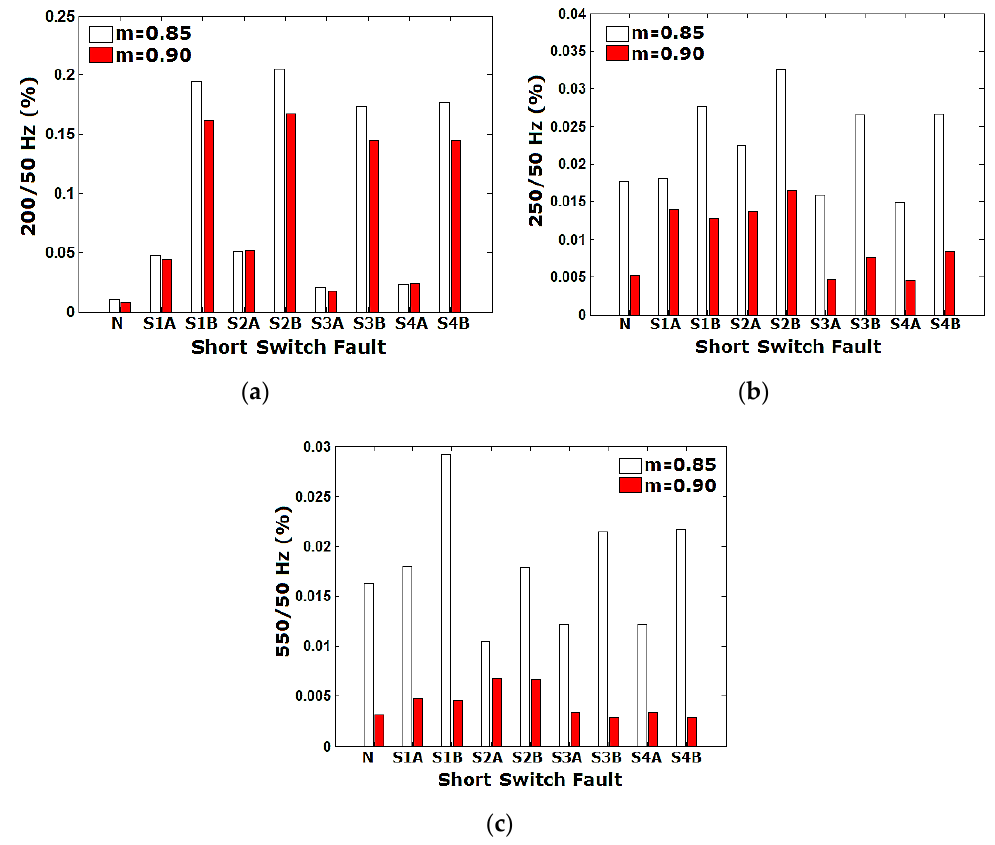
Figure 9. Features of the voltage waveform acquired from the FFT technique at distinct short switch fault cases ( a ) 4th harmonic ratio, ( b ) 5th harmonic ratio, ( c ) 11th harmonic ratio.